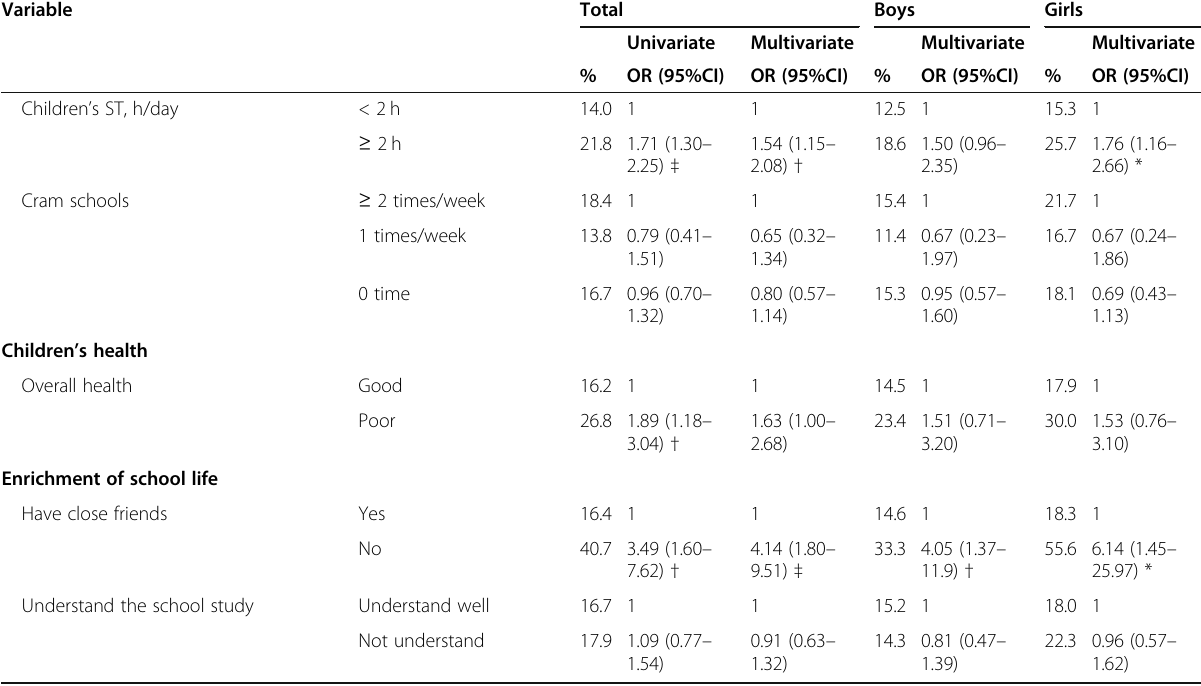
Table 4 Logistic regression analysis results for “ Lack of physical activity ” regardless of “ Prefer physical activity ” ( n = 1486) (Continued) Variable